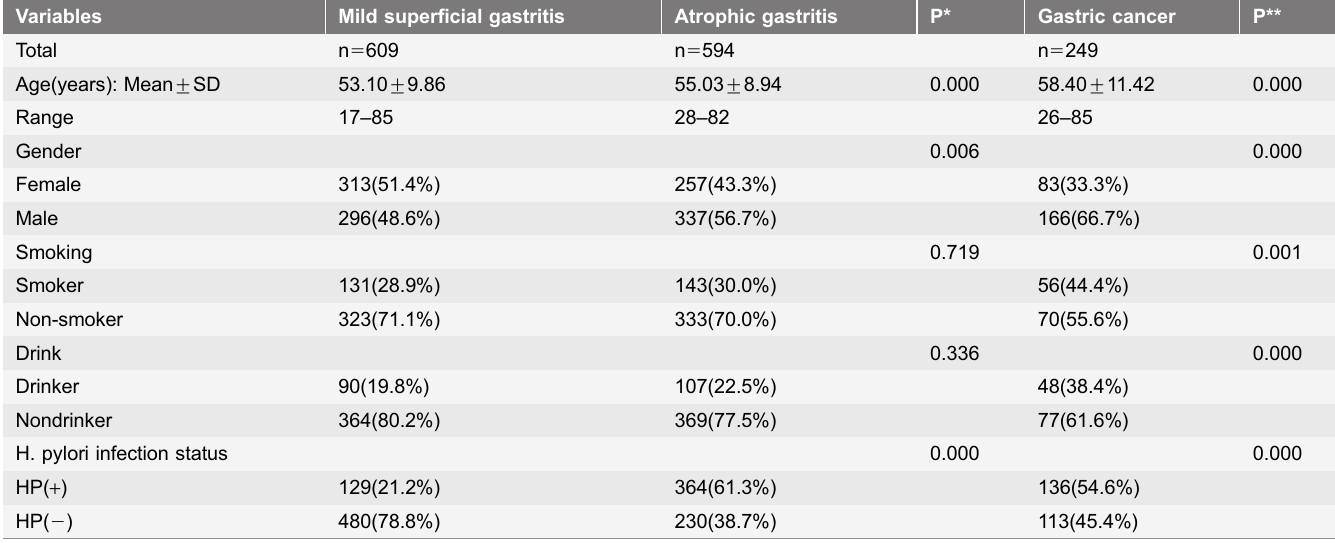
Table 1. Characteristics of the study